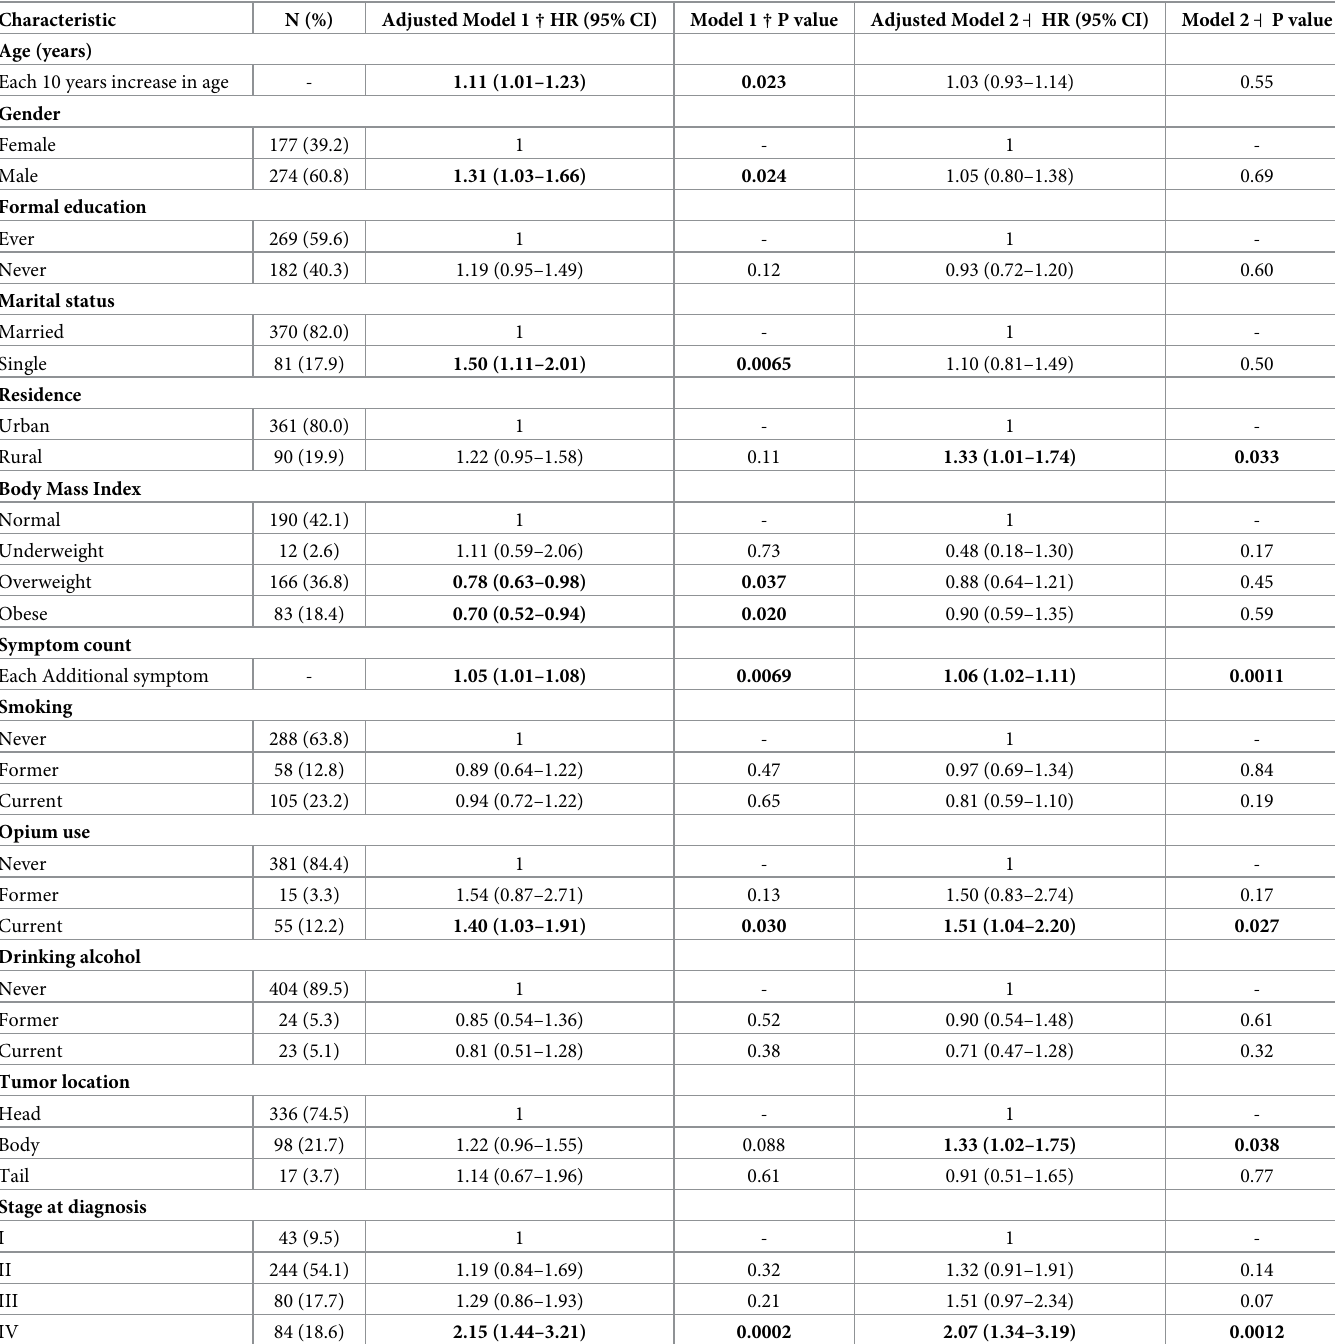
Table 5. Association between different demographical, clinical, and therapeutic factors with risk of death from pancreatic cancer.